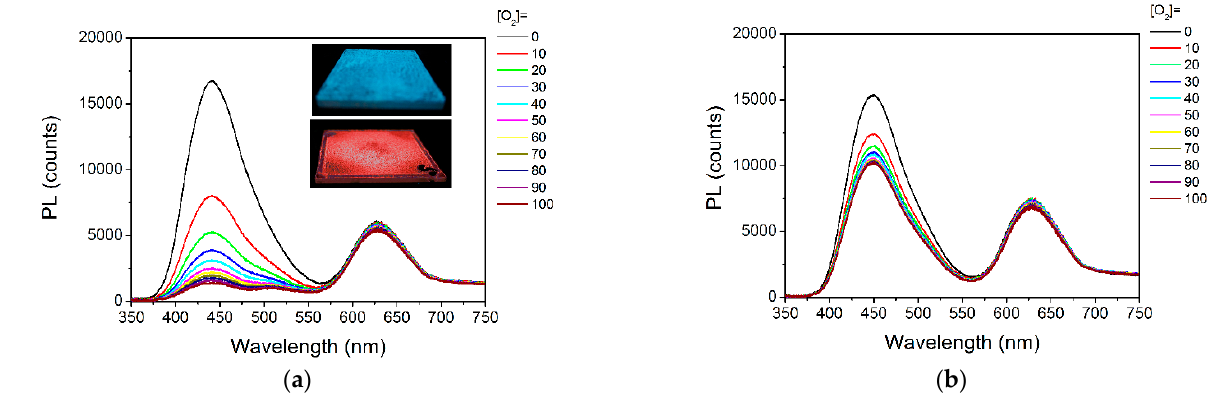
Figure 10. Emission spectra of CuPBr-COF ( a ) and CuPCl-COF ( b ) upon various O 2 levels. Inset: photos of CuPBr-COF upon pure N 2 (top inset) and pure O 2 (bottom inset) atmosphere upon excitation light of 350 nm.